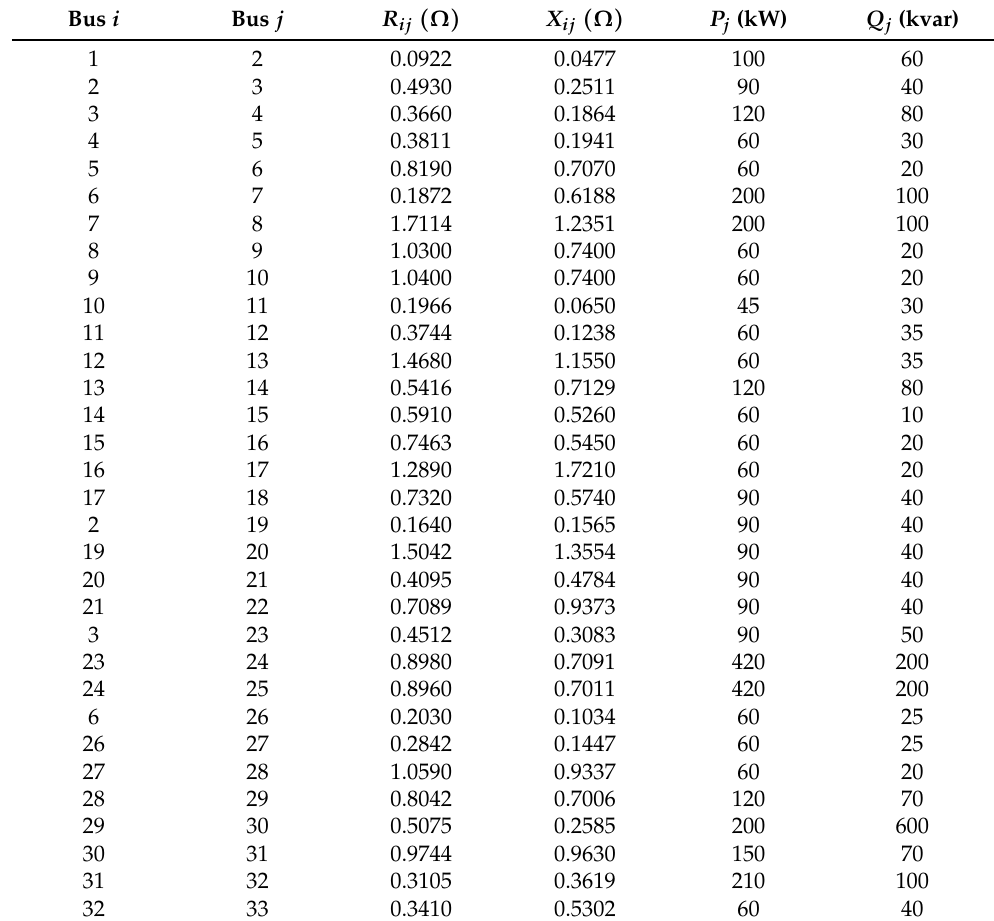
Table 2. Electrical parameters for the 33-bus IEEE network with a radial structure.